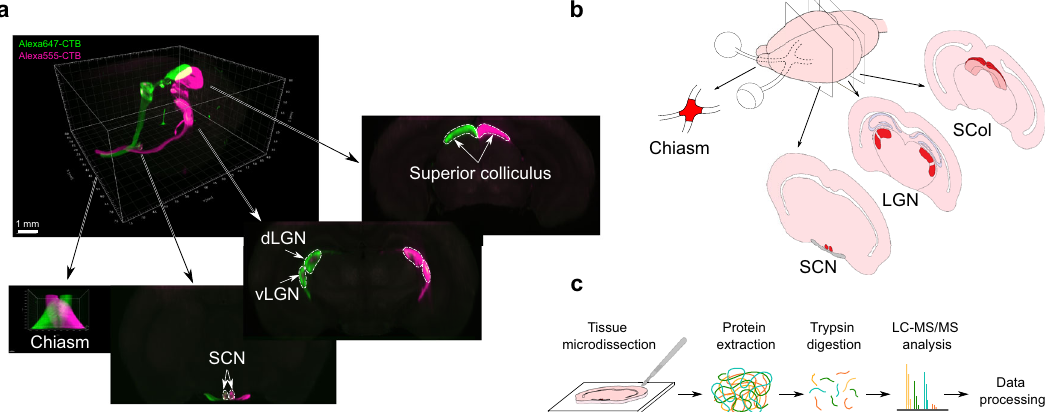
Fig.1|Proteomicanalysisofadultvisualtargets.a 3Dclearedbrainimagedusing light sheet microscopy highlighting the regions of interest. The two eyes were injected with Alexa555-conjugated CTB and Alexa647-conjugated CTB to allow visualization of ipsi- and contralateral projections within each visual brain target. b Diagram of the mouse visual targets used for the study. Primary targets of RGC